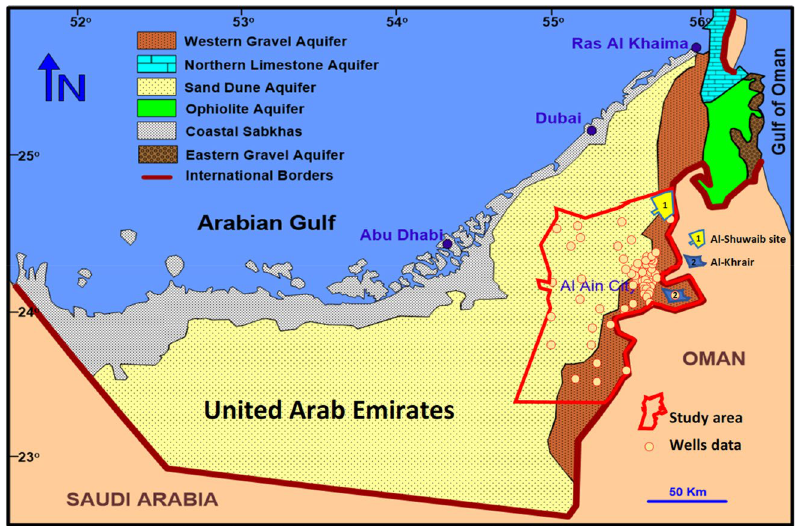
Figure 1. Map of the United Arab Emirates showing the study area (Al Ain region), the hydrological aquifers, and the two selected sites (Al-Shuwaib and Al-Khrair) (Modified after Rizk and Alsharan 39 using ArcMap 10.8 https:// www. esri.